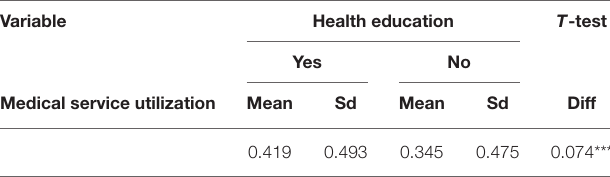
TABLE 2 | The gap in medical service utilization between the migrants with and without health education.